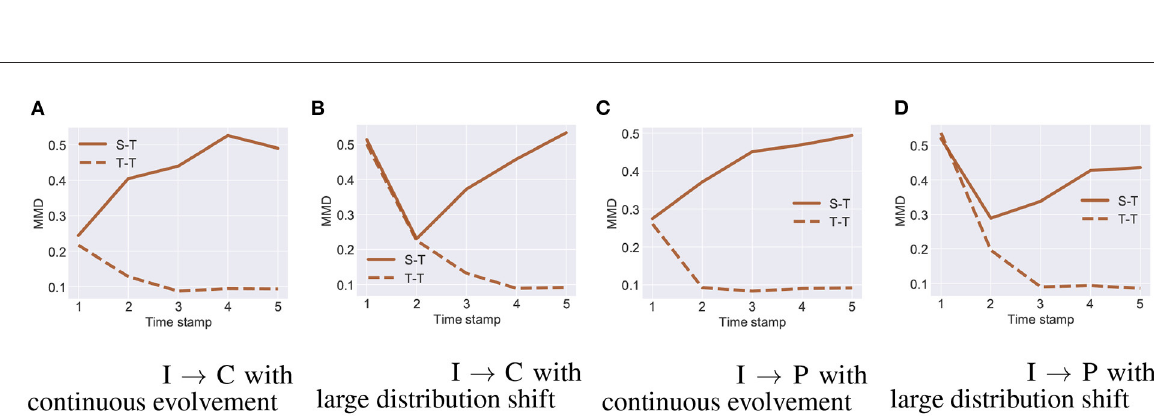
FIGURE4 I C on ImageCLEF-DA with (A) continuous evolvement, (B) large distribution shift. I → (D) large distribution shift.